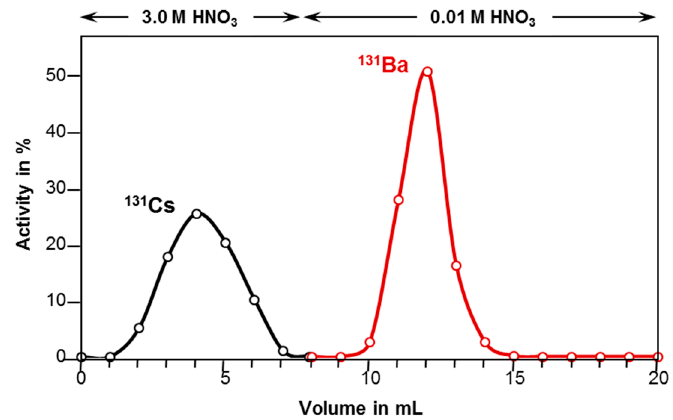
Figure 4. Elution profile of the barium-131 separation from a 80 mg CsCl target (6 mm × 100 mm Sr Resin column, gradient elution).